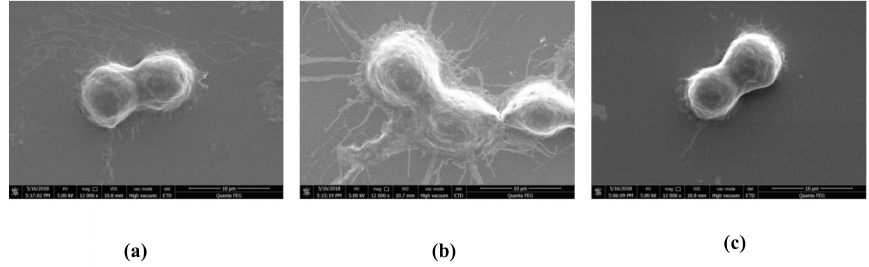
Figure 3. Photograph of RAW264.7 cells after incubation with LPS and HOA under scanning electron microscopy (SEM). ( a ) Control; ( b ) LPS treatment; ( c ) LPS and HOA treatment.